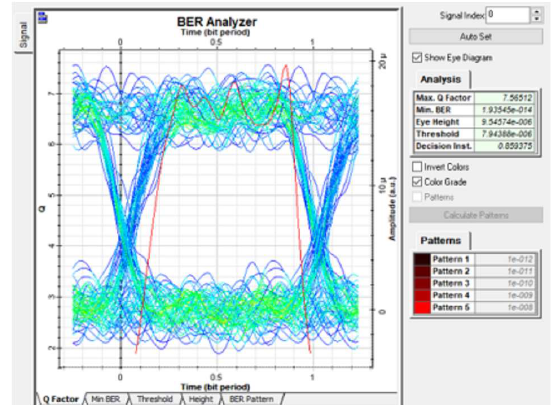
Figure 4. Simulation results 16 channel WDM system BER tester with eye diagram